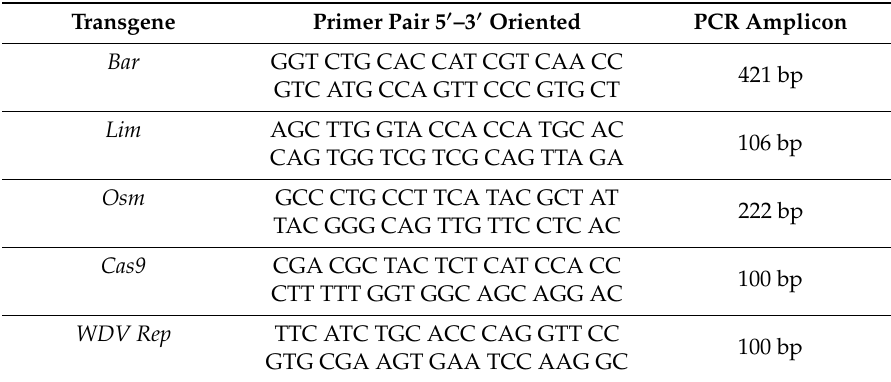
Table 3. List of RT-PCR primers and amplicon sizes.